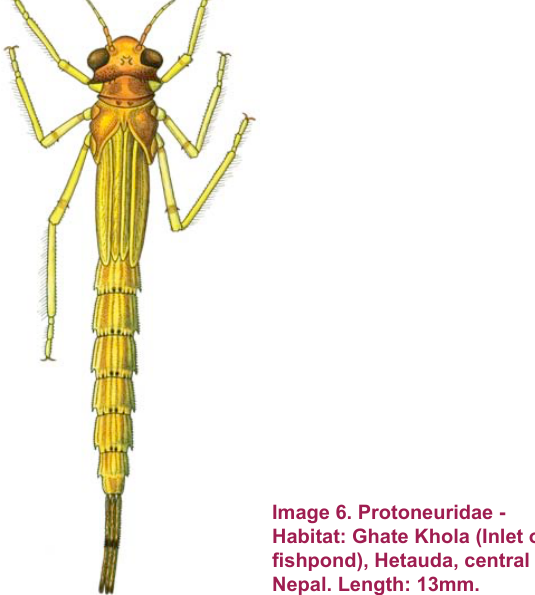
Image 6. Protoneuridae - Habitat: Ghate Khola (Inlet of fishpond), Hetauda, central Nepal. Length: